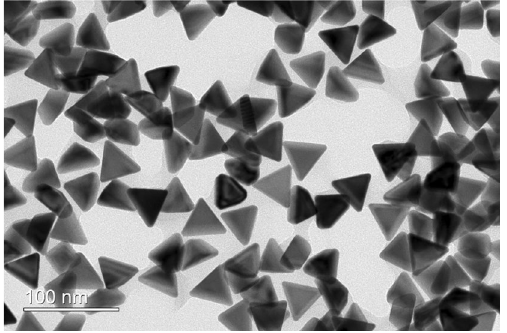
Figure 4. TEM image of Au nanoplates with an edge length of 45